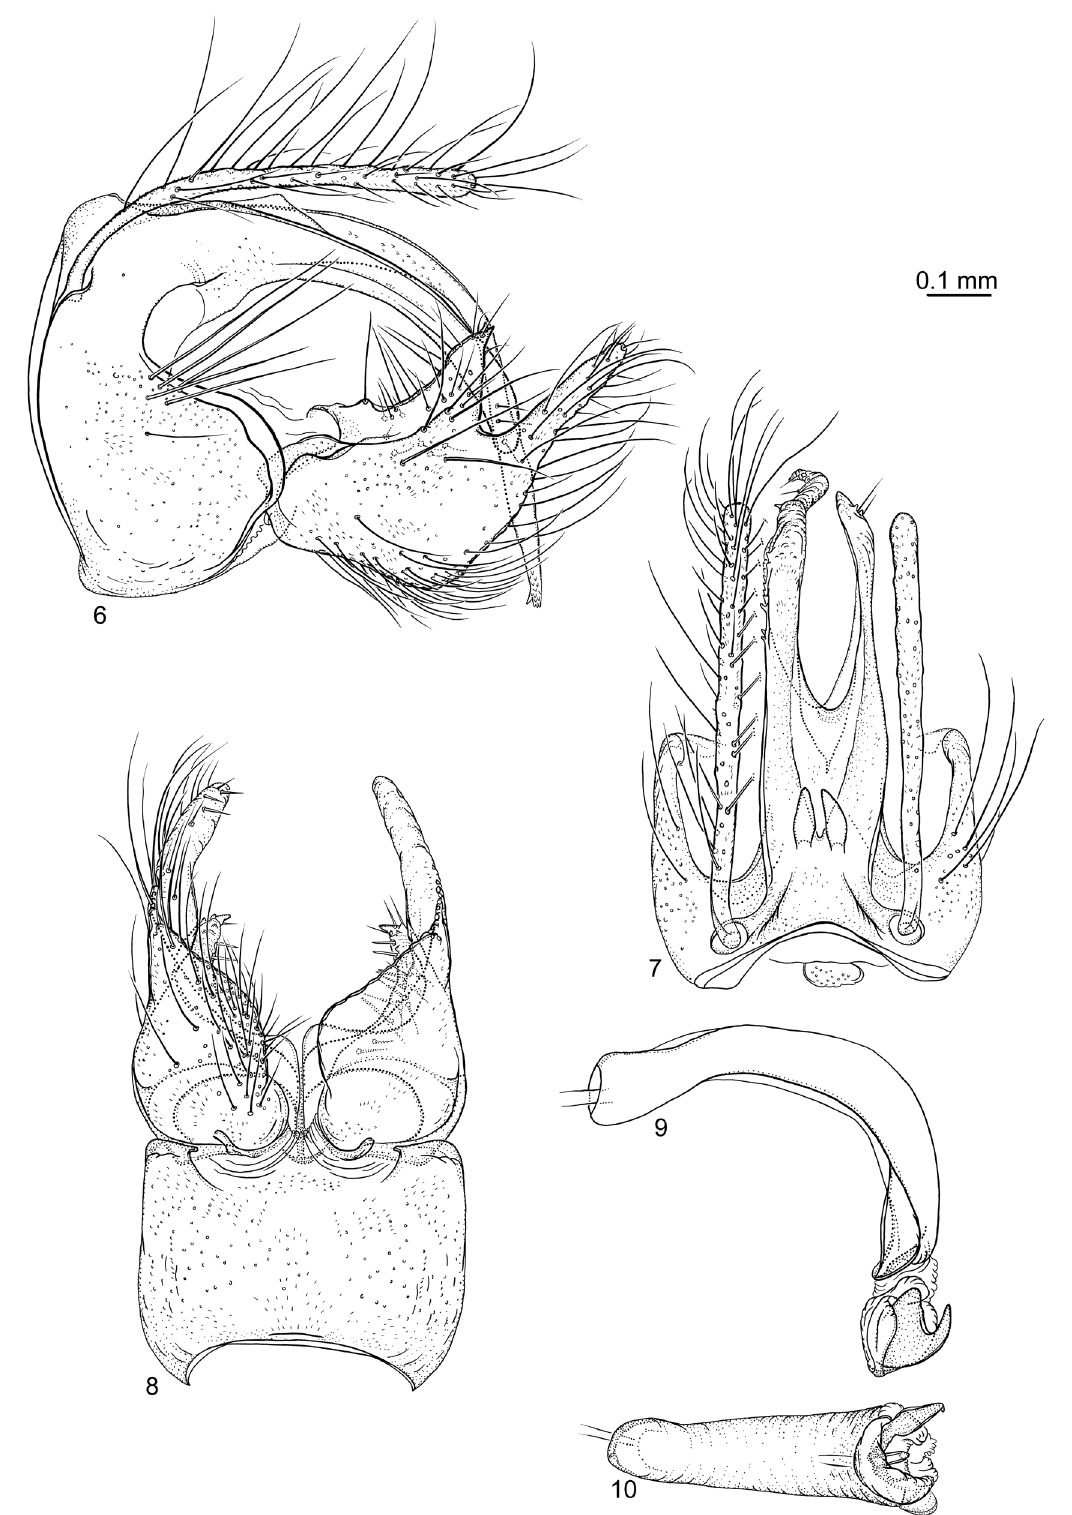
Figs 6–10. Oecetis apelqvisti sp. nov., holotype, ♂ (NHRS). 6 . Genitalia, lateral view. 7 . Genitalia, dorsal view. 8 . Genitalia, ventral view. 9 . Phallus, lateral view. 10 . Phallus, ventral view. Scale bar = 0.1